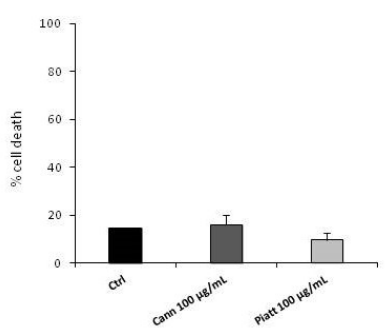
Figure 4. BF does not induce cell death. Cell toxicity of Cannellino and Piattellino BF (100 µ g/mL) was evaluated by trypan blue assay. HT29 cells were exposed to treatments for 48 h, and dead cells were labeled by using the trypan blue reagent. Blue cells were counted using a LUNA-II Automated Cell Counter (Logos Biosystems). Data are reported as % of cell death and are the means of three experiments run in triplicate. Ctrl: untreated cells.